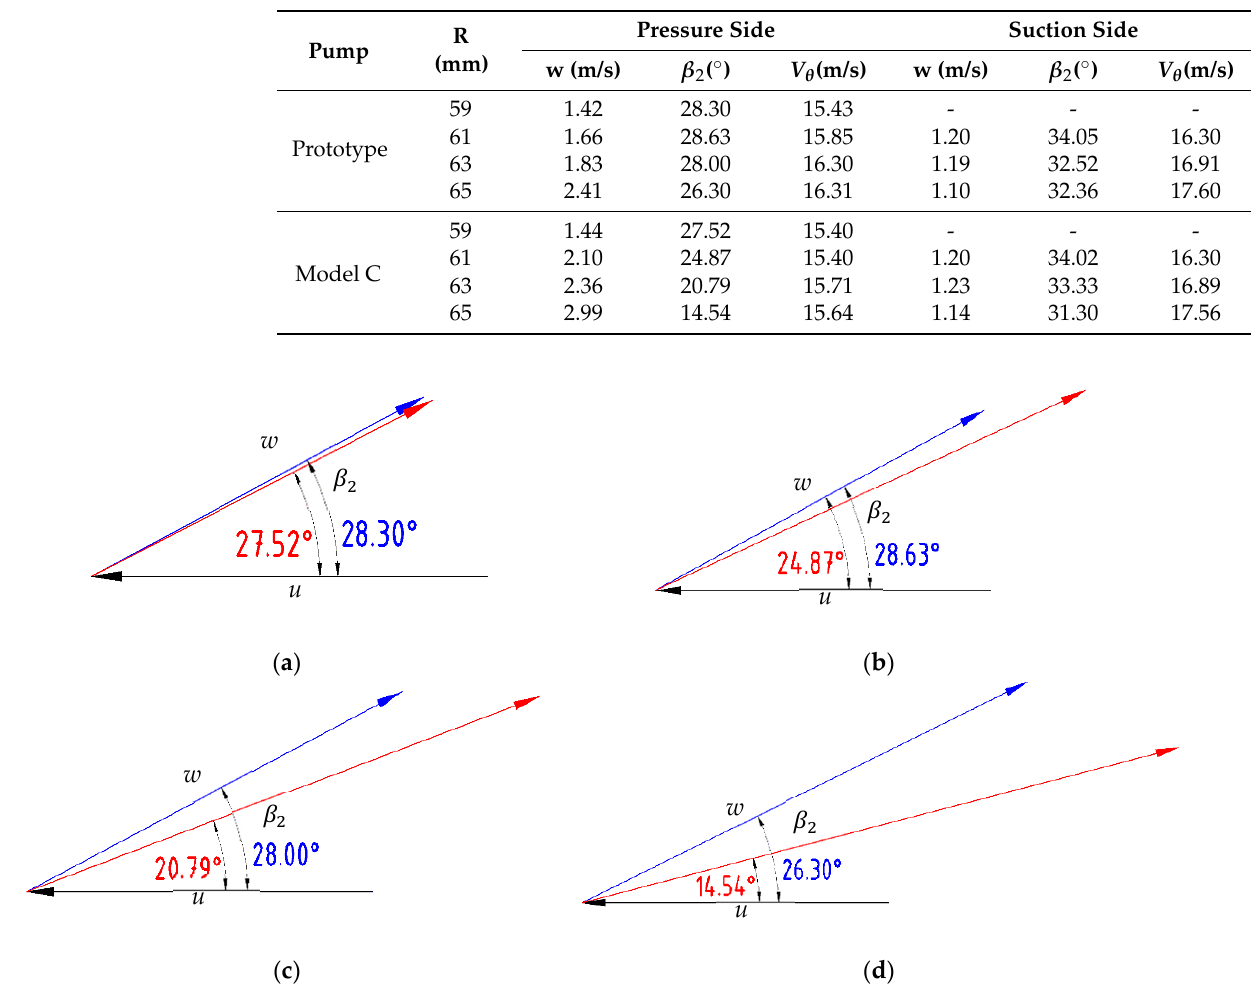
Figure 15. Pressure side velocity vector triangle of averaged local velocities in Table 3: ( a ) R = 59 mm; ( b ) R = 61 mm; ( c ) R = 63 mm; ( d ) R = 65 mm. Black: peripheral velocity; blue: relative velocity of the prototype; red: relative velocity of Model C.